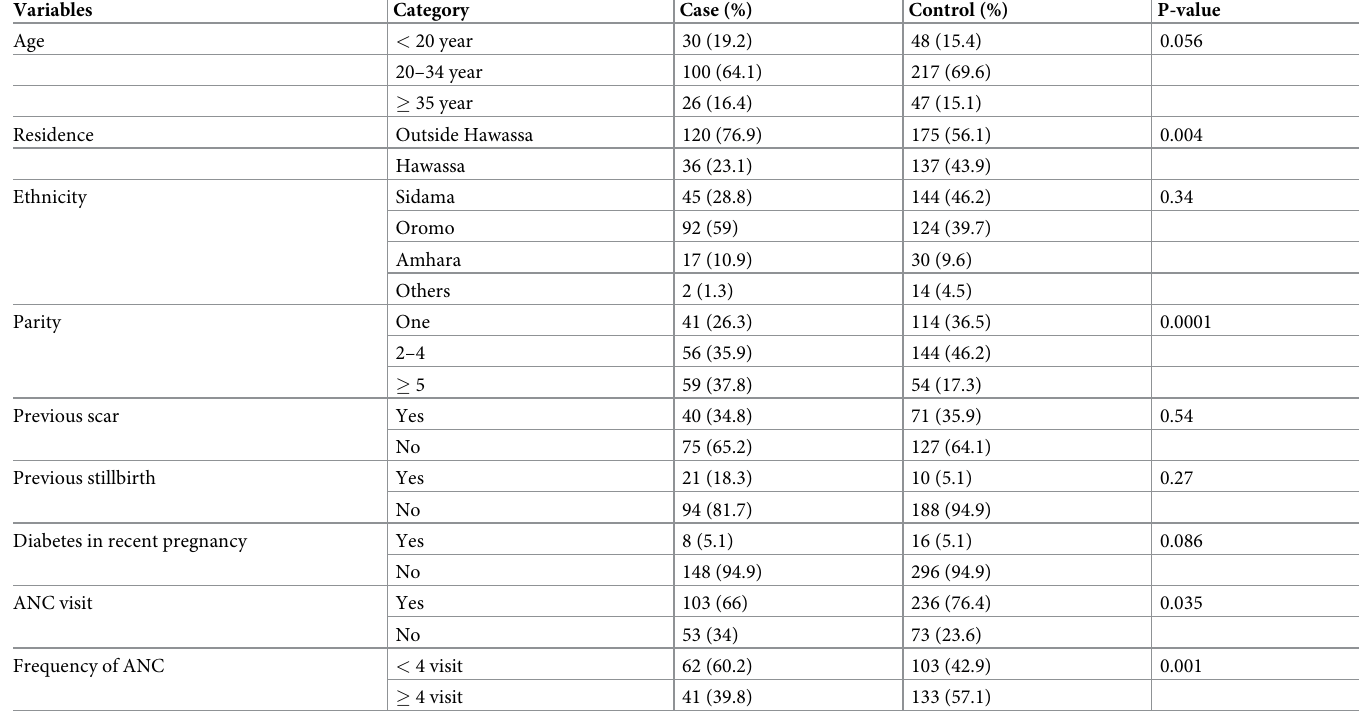
Table 1. Sociodemographic and antenatal characteristics of women who gave birth in HUCSH from 2015–2017. Sociodemographic and prenatal characteristics of participants in HUCSH, 2018.